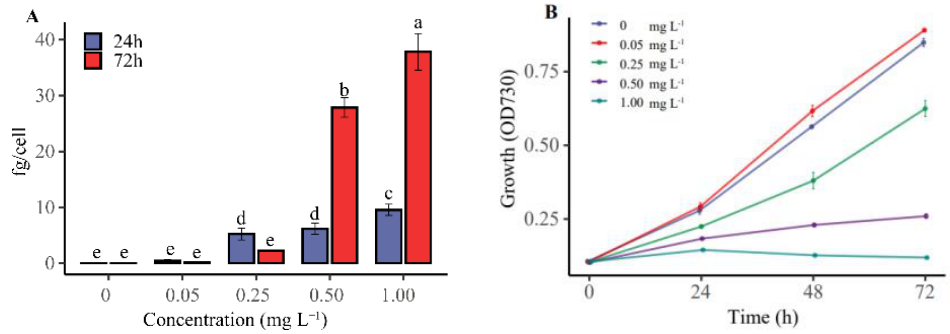
Figure 1. Algal cells were treated with cadmium at different concentrations for 72 h. ( A ) Intracellular cadmium content. ( B ) Growth curve. The mean and standard deviation of three replicates were shown in the figure. According to the one − way ANOVA test, different alphabet letters indicated a significant difference in different groups at p < 0.05.